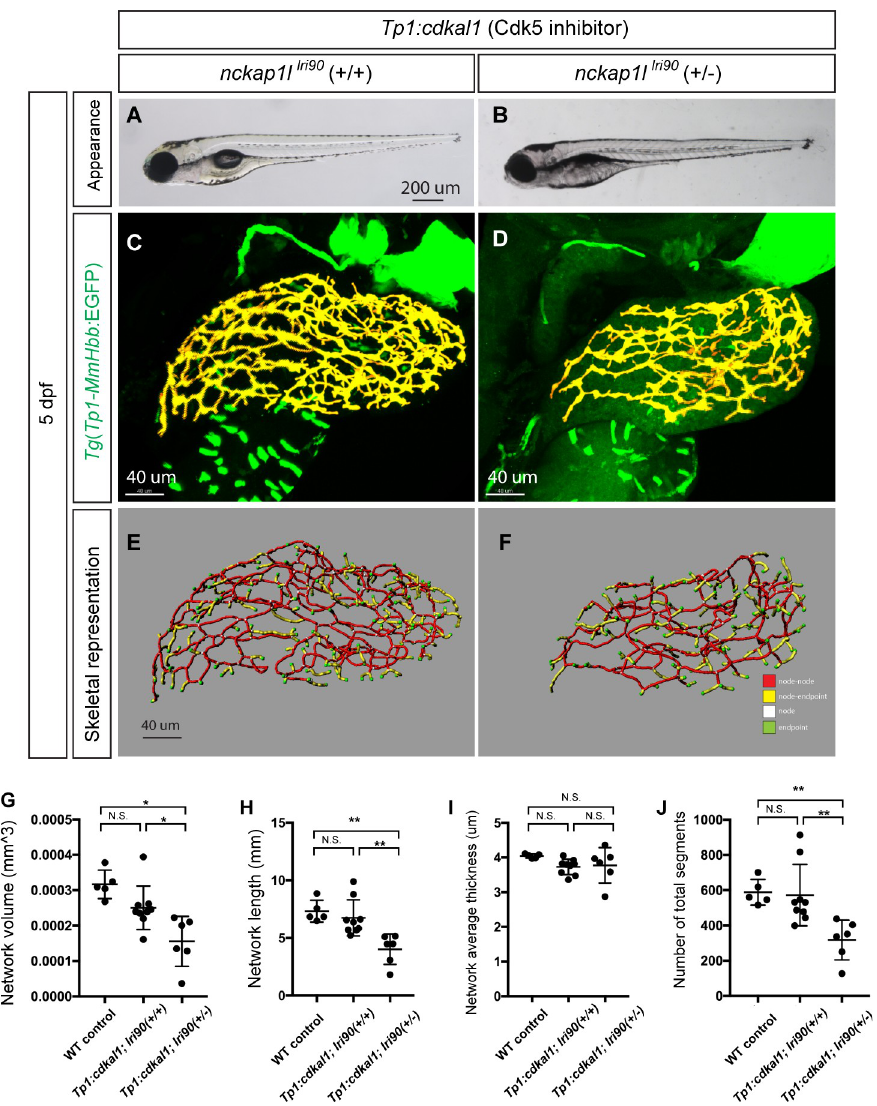
Fig 5. Dosage-sensitive genetic interaction between nckap1l and cdk5 indicates these two genes function as part of the same pathway. (A and B) Representative physical appearance of Tg(tp1 : cdkal1) kl109 larvae ( nckap1l lri90(+/+) ; Tg(tp1